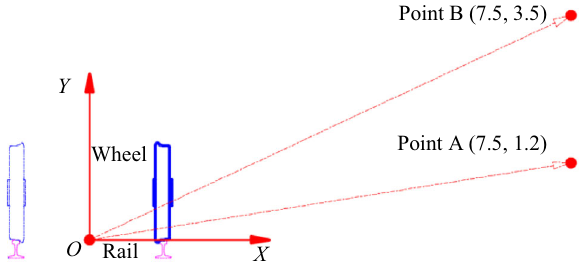
Fig. 7 Standard measurement points